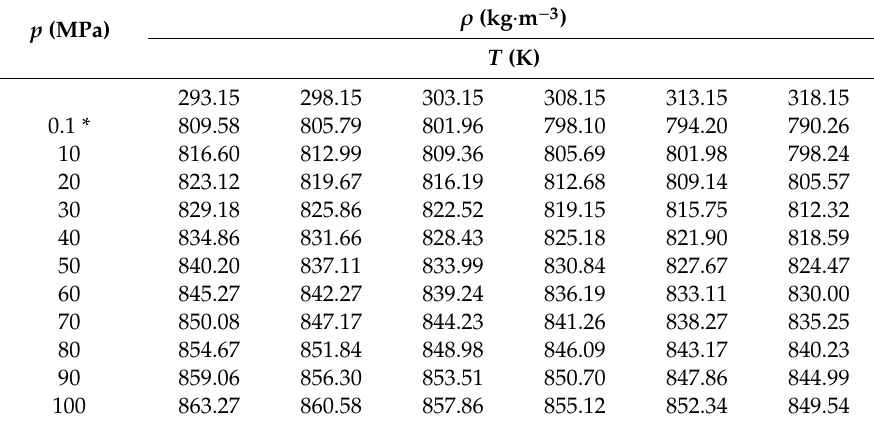
Table 5. The density, ρ , of 1-butanol at pressures up to 100 MPa and within the temperature range from (293 to 318) K.